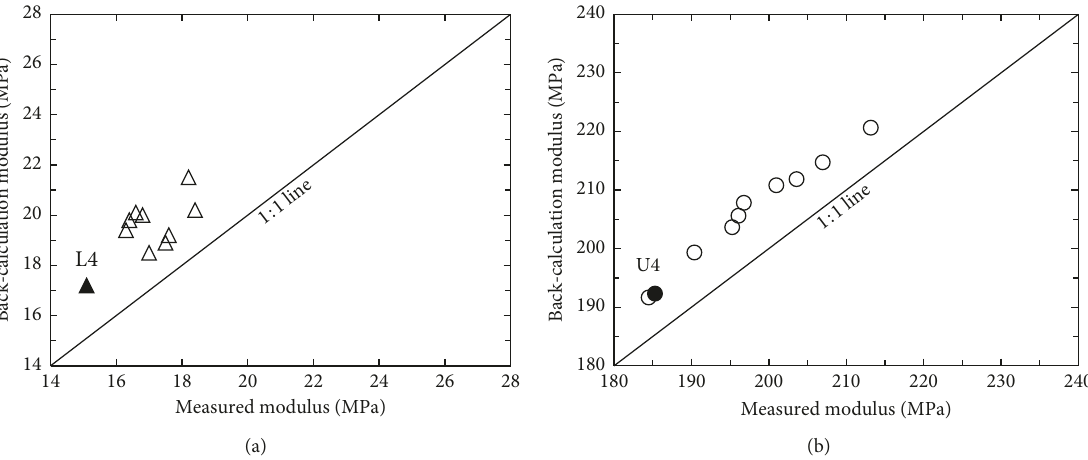
Figure 11: Comparison of back-calculated moduli using VEM and measured moduli using PLT. (a) Results of L1–L10. (b) Results of